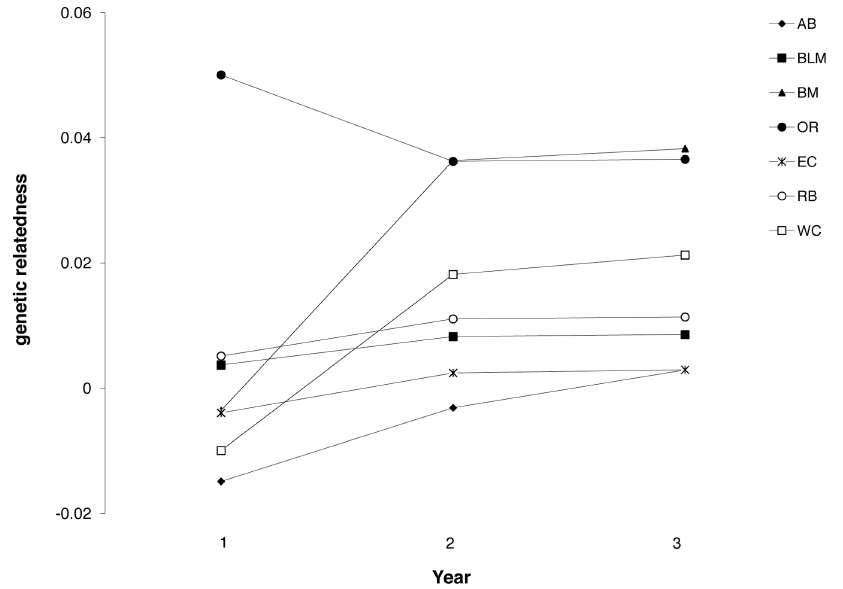
Figure 3. Temporal trends in genetic relatedness. Estimates of mean genetic relatedness within each burned area during the first, second and third year of sampling. Second and third years represent cumulative estimates of relatedness, that is, samples in year two include samples from both year one and year two. doi:10.1371/journal.pone.0067248.g003 PLOS ONE |